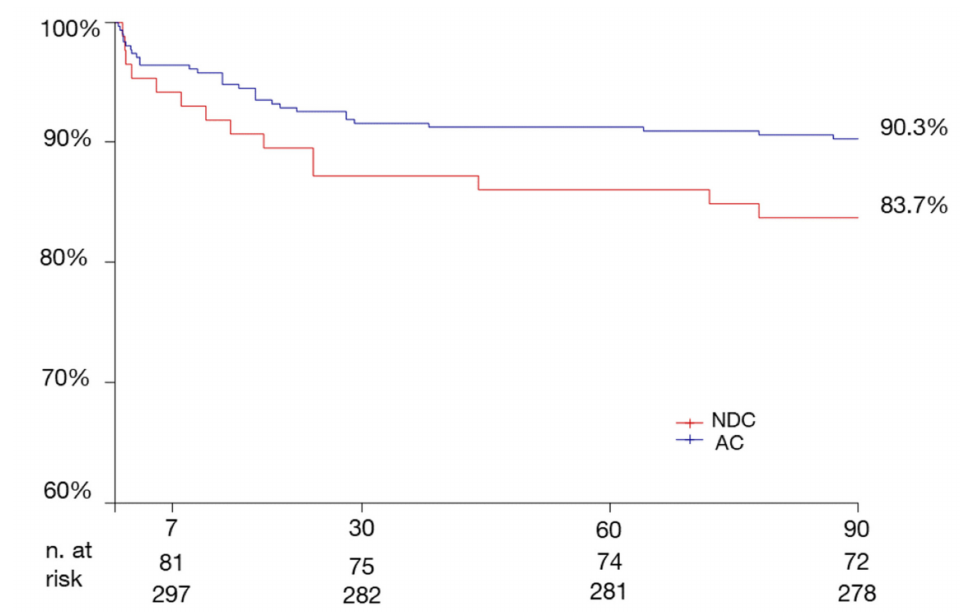
Figure 1. Months after the index stroke in NDC and AC patients. Log rank test = 2.9, ( p > 0.05). Table 1. Patient characteristics and results. Continuous and ordinal variables are expressed as medi- ans (with interquartile range, IQR), and categorical variables as absolute counts (with percentage). Results from the univariate analysis in the “NDC” and “AC” groups are reported as odds ratio (OR) and 95% confidence interval (CI). PFO: patent foramen ovale; mRS: modified Rankin